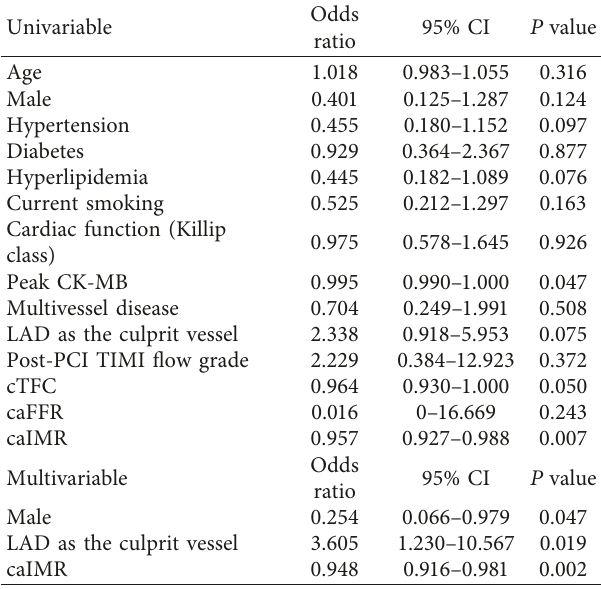
Table 4: Logistic regression analysis for the left ventricular re- covery at 3 months.